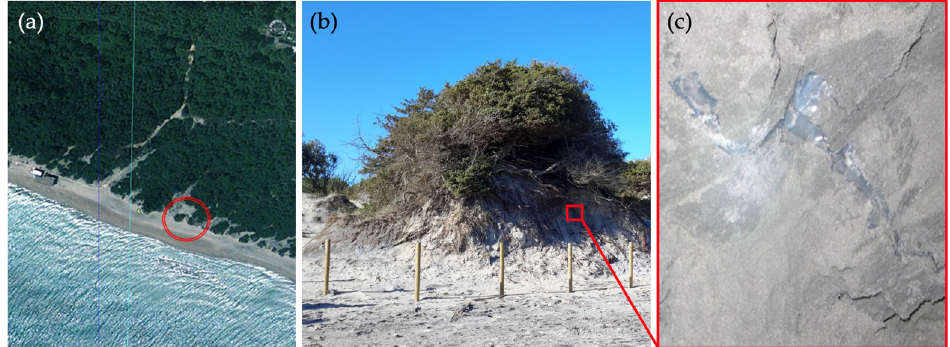
Figure 6. Aerial view of the intervention site ( a ), visual observation of the restored dune six months after the intervention ( b ), and detail of the consolidated dune face ( c ). Photo courtesy of Giuseppe Roberto Tomasicchio.